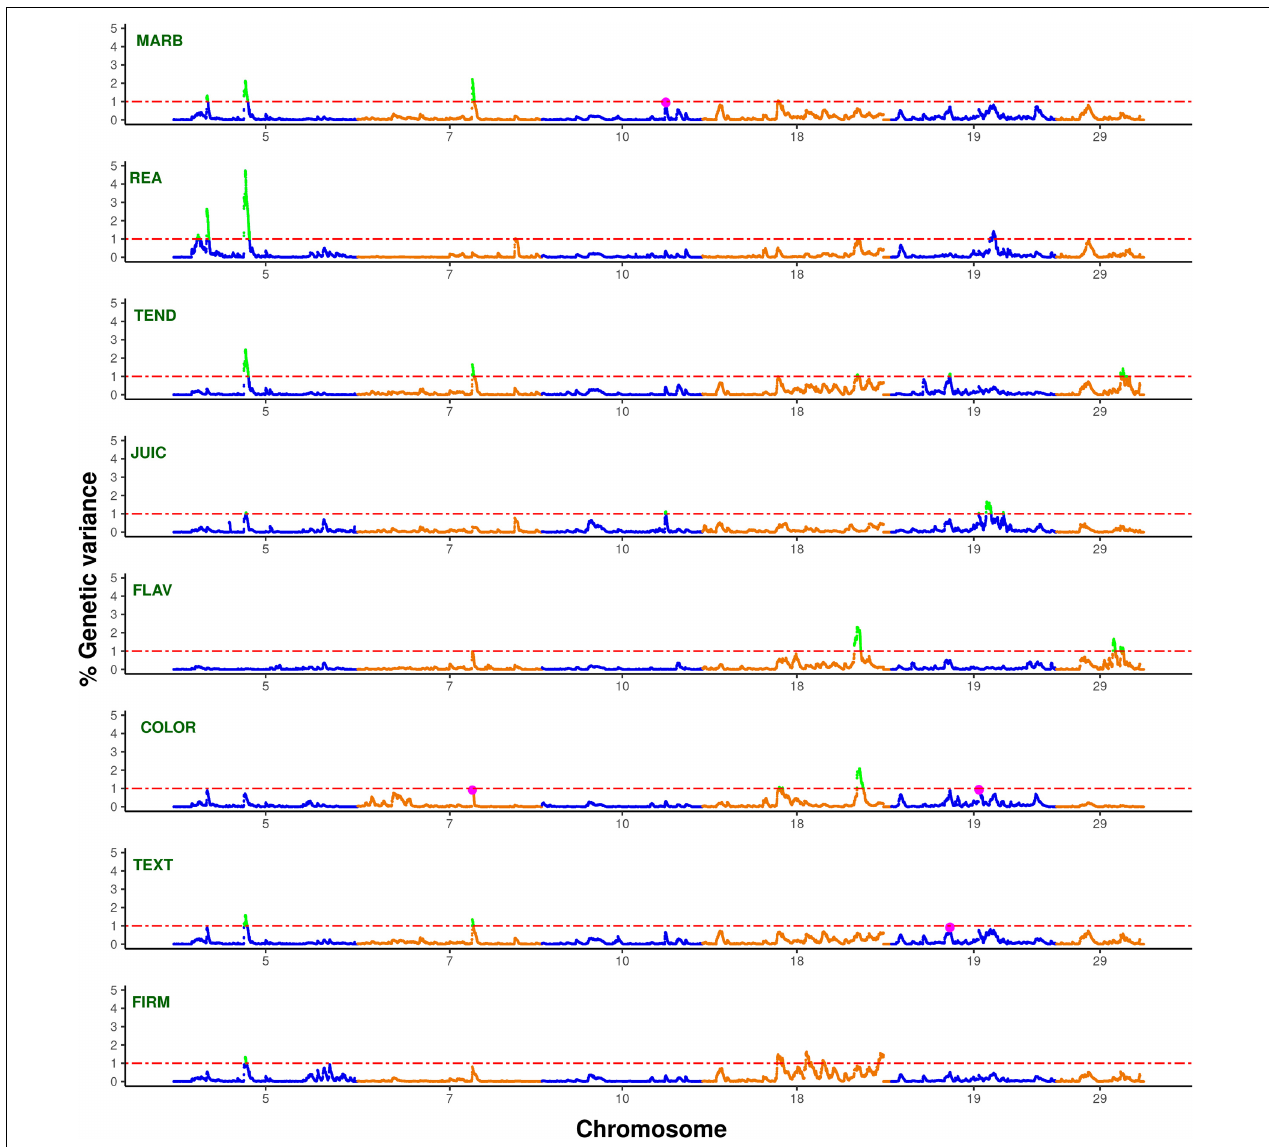
FIGURE 1 | Manhattan plots for bovine chromosomes harboring pleiotropic regions with effect on MARB, REA, TEND, JUIC, FLAV, COLOR, TEXT, and FIRM with significance thresholds indicated at 1% of the additive genetic variance (dash-dotted red line). The variance explained by 1-Mb genomic windows was estimated using single-trait WssGBLUP analyses correcting for indirect effects (i.e., including all remaining traits as covariates). The pleiotropic regions were highlighted in green, and suggestive pleiotropic regions were highlighted in